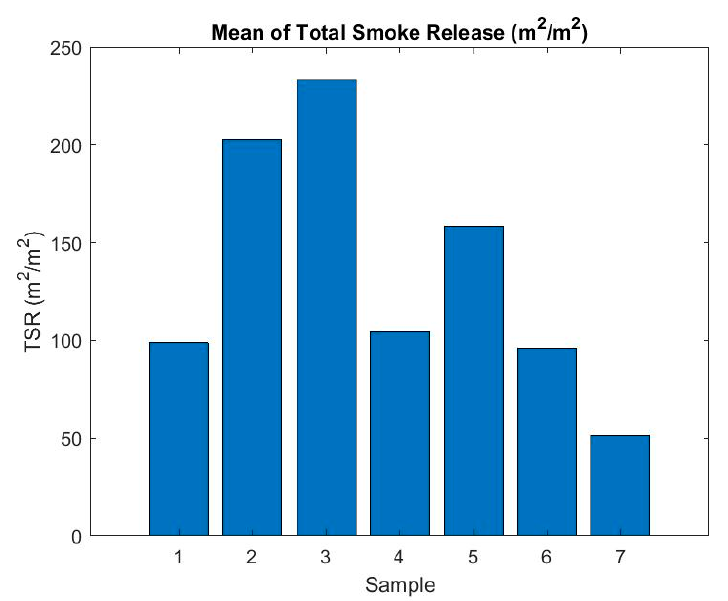
Figure 5. Mean of total smoke release (m 2 /m 2 ).